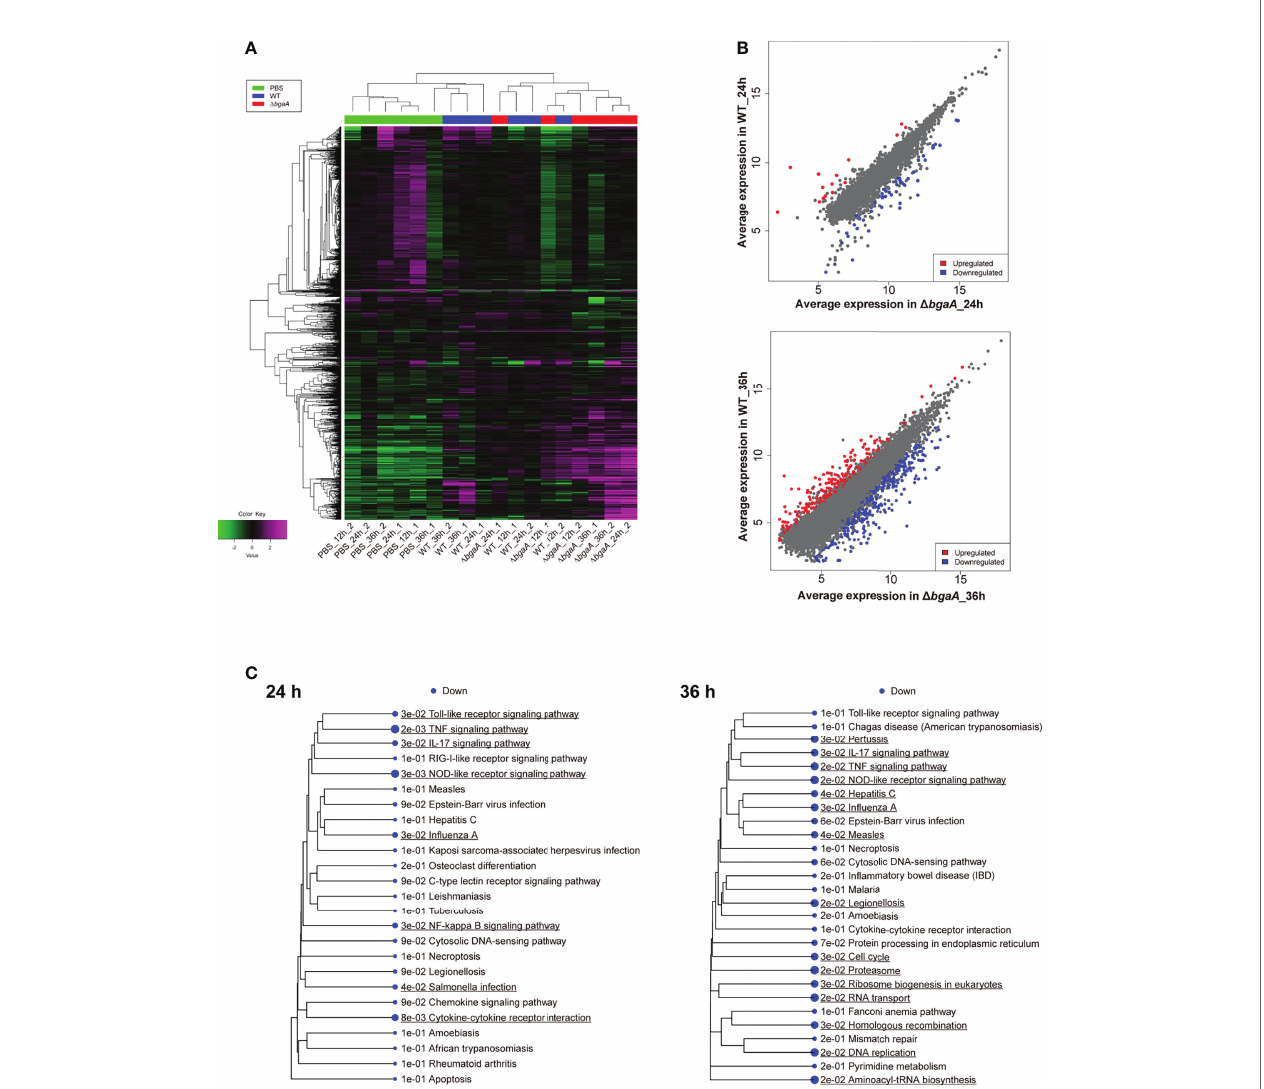
FIGURE 4 | Mouse blood RNA-seq analysis revealed that de fi ciency of bgaA up-regulated several innate immune pathways. RNA-seq analysis was performed using mouse blood at 12, 24 and 36 h after infection. All analysis and visualizations were performed using the iDEP package. (A) Heatmap with hierarchical clustering of most variable 1,000 genes. The data is centered by subtracting the average expression level for each gene. (B) Scatter plots illustrating host genes consistently altered among WT-infected and D bgaA -infected mice 24 and 36 h after infection. Differentially expressed genes were calculated using DESeq2. FDR cutoff value was 0.1 and Min fold change was 2. (C) Pathway trees. Enrichment pathway analyses were performed by GAGE using KEGG pathways. Circle sizes represent FDR values. FDR cutoff value was